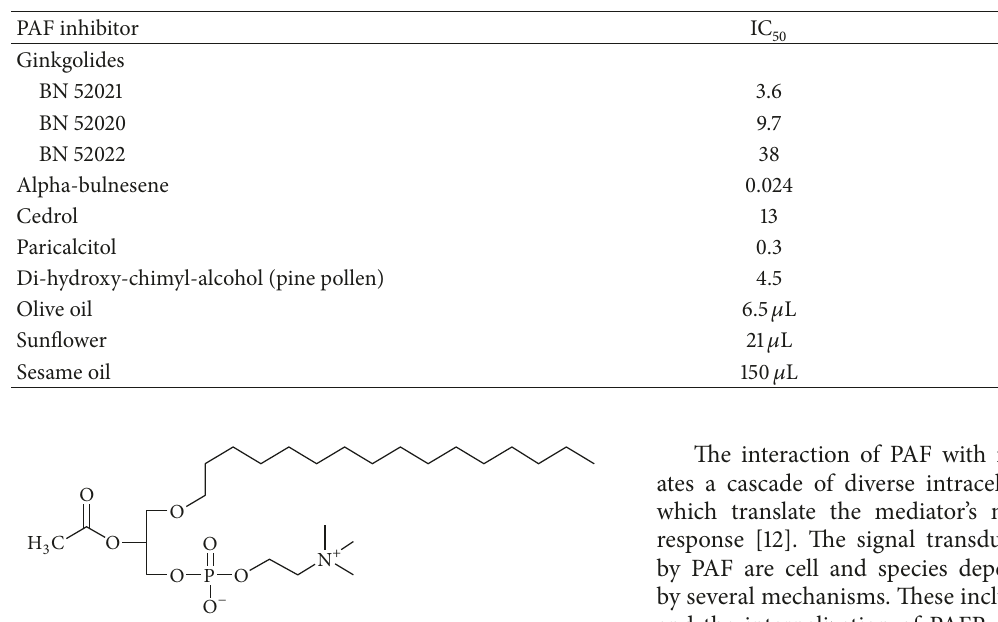
Table 1: IC 50 ( 𝜇 M, final concentration) of various PAF inhibitors that induces 50% inhibition against PAF aggregation in washed rabbit platelets (WRPs). IC 50 ( 𝜇 L) values are expressed in microliters of initial volume of oil that induces 50% inhibition against 1 × 10 −11 M PAF final concentration in the aggregometer cuvette.